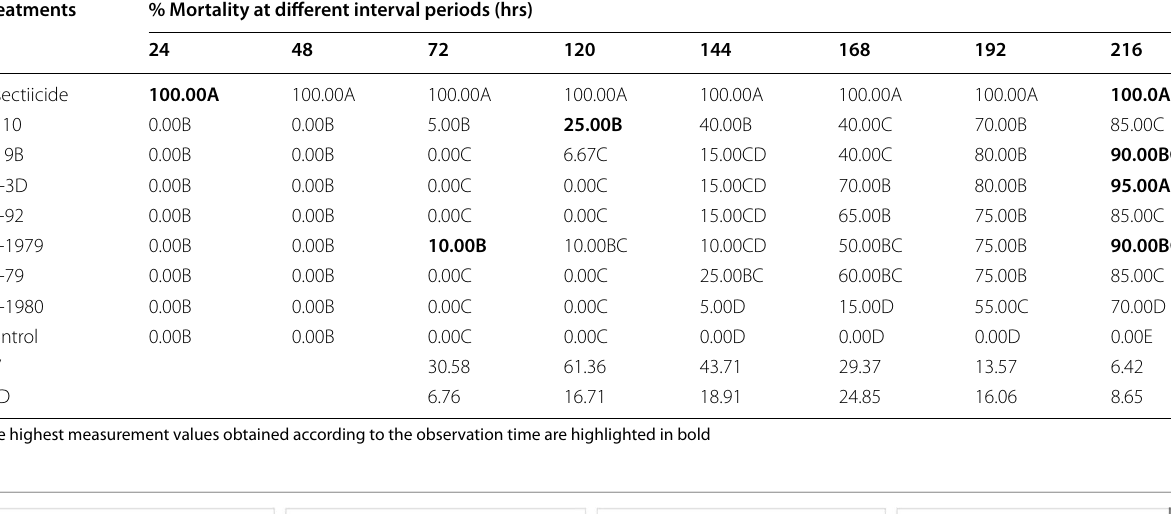
Table 3 Virulence effect of the applications on the last instar larvae of Cymbalophora rivularis Treatments